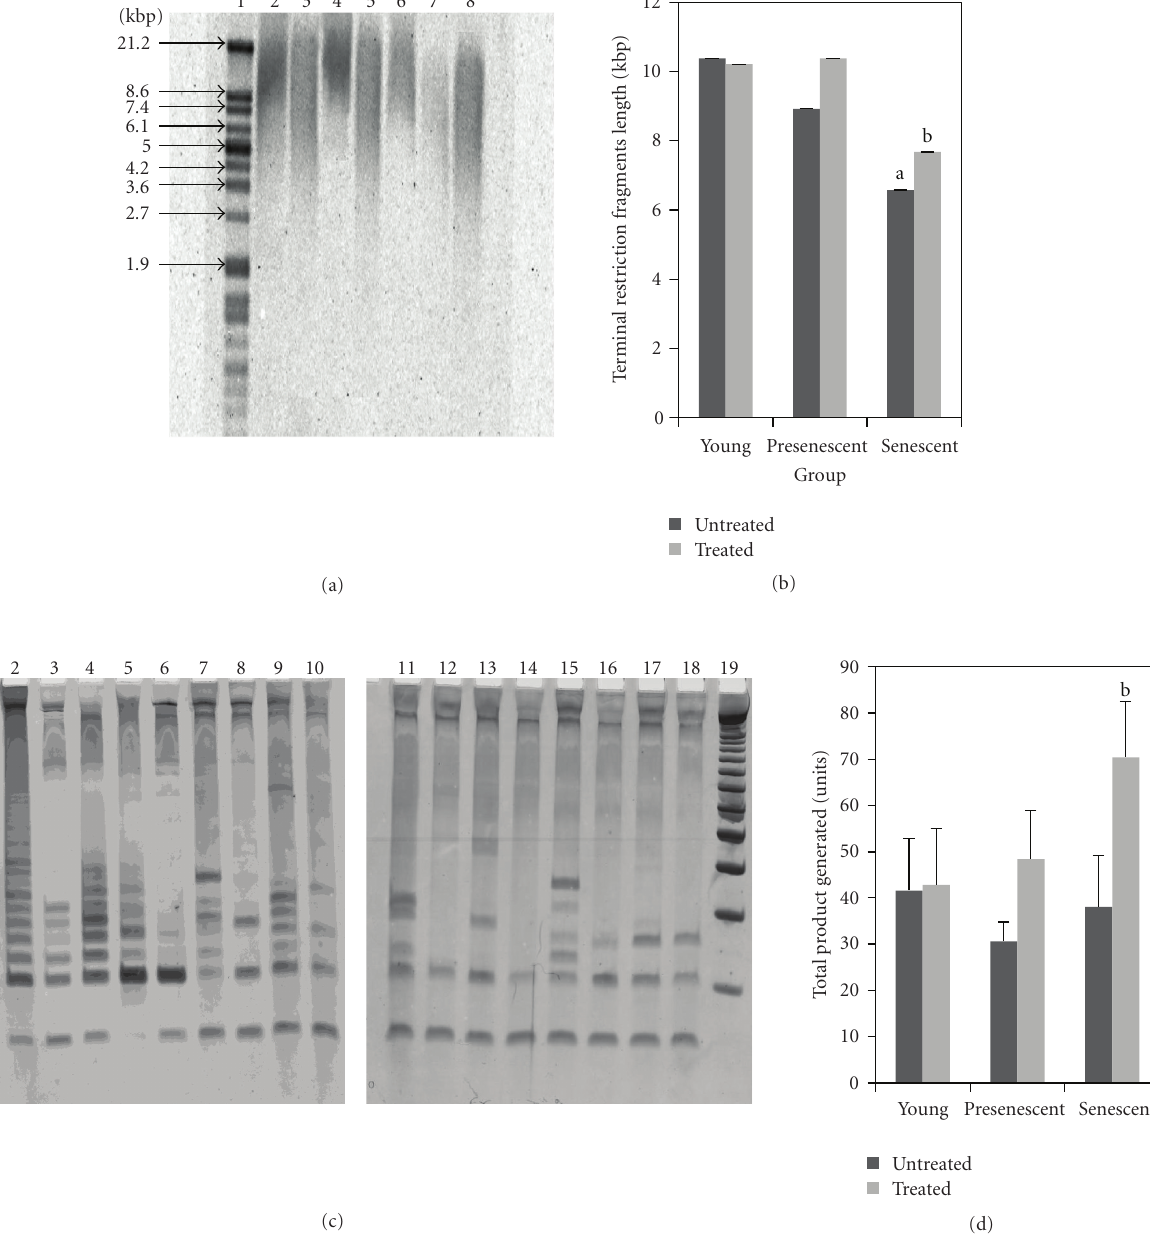
Figure 7: E ff ects of tocotrienol-rich fraction (TRF) on telomere length and telomerase activity. Representative Southern blot analysis of young, presenescent and senescent HDFs. Telomeric DNA is shown as wide smears in all lanes. Lane 1: molecular weight marker, lane 2: positive control DNA, lane 3: untreated young HDFs, lane 4: TRF-treated young HDFs, lane 5: untreated presenescent HDFs, lane 6: TRF-treated presenescent HDFs, lane 7: untreated senescent HDFs, lane 8: TRF-treated senescent HDFs (a). Telomere length (Terminal Restriction Fragments) of young, presenescent and senescent HDFs. Shortening of telomere length was observed with senescence of HDFs. Protective e ff ects of TRF against telomere shortening was observed in senescent HDFs. a Denotes P < . 05 compared to untreated young HDFs, b activity of young, presenescent and senescent HDFs. Lane 1: molecular weight marker, lane 2: positive control, lane 3: positive control